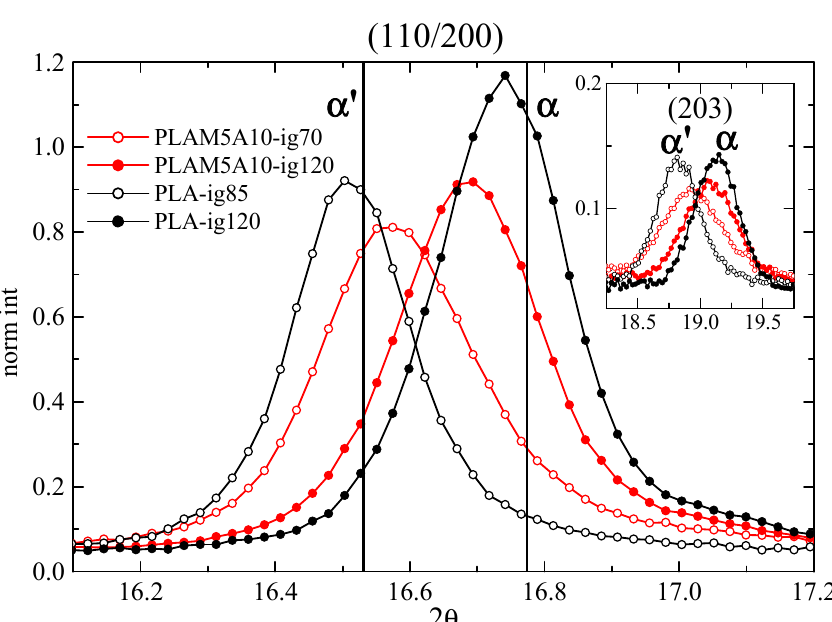
Figure 14. Room-temperature X-ray diffractograms of different samples after cold crystallization from the amorphous glassy state at the indicated temperatures, showing the angular interval of the main (110/200) diffraction and that for the (203) reflection one in the inset. The vertical lines are the corresponding values reported in ref. [33] for the pure α ’ and α modifications.